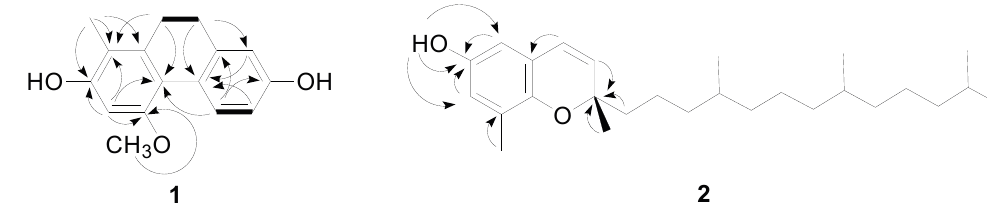
Figure 2. Key COSY ( ▬ ) and HMBC ( → ) correlations of 1 and 2 .